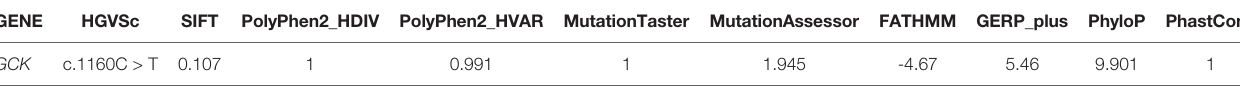
TABLE 4 | Pathogenicity results of candidate gene mutation sites predicted by bioinformatics analysis. GENE HGVSc SIFT PolyPhen2_HDIV PolyPhen2_HVAR MutationTaster MutationAssessor FATHMM GERP_plus PhyloP PhastCons GCK